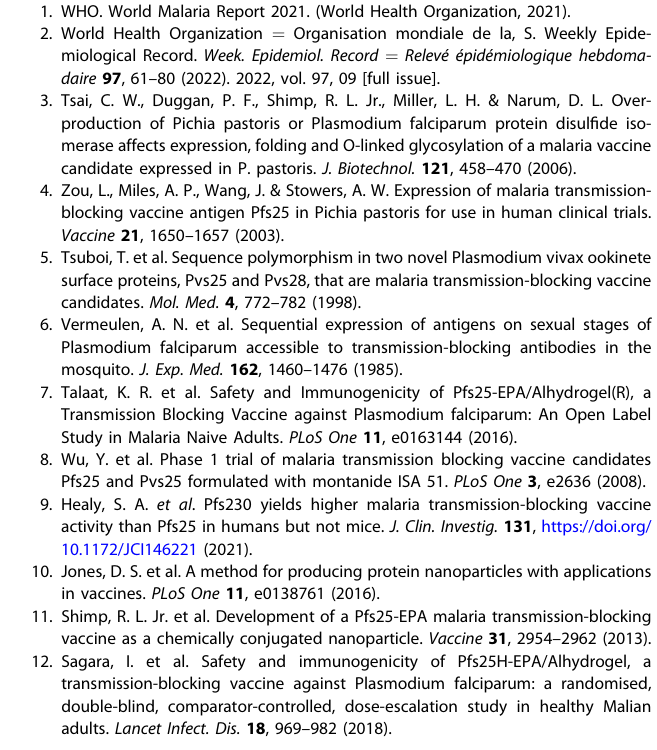
Table 1) 25 . Molecular replacement using in-house